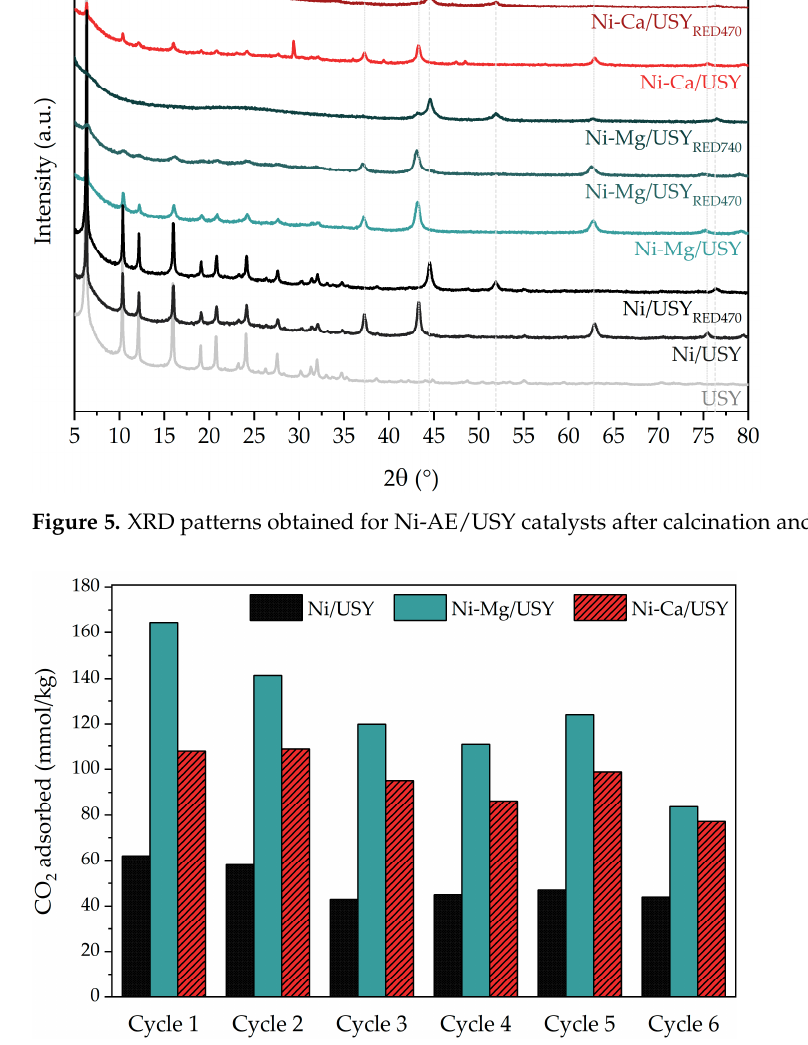
Figure 6. CO 2 adsorption capacity of Ni/USY and Ni-AE/USY catalysts under cyclic experiments. Adsorption was performed at 150 °C (CO 2 /N 2 ; 60 min) and desorption at 450 °C (N 2 ; 10 min).